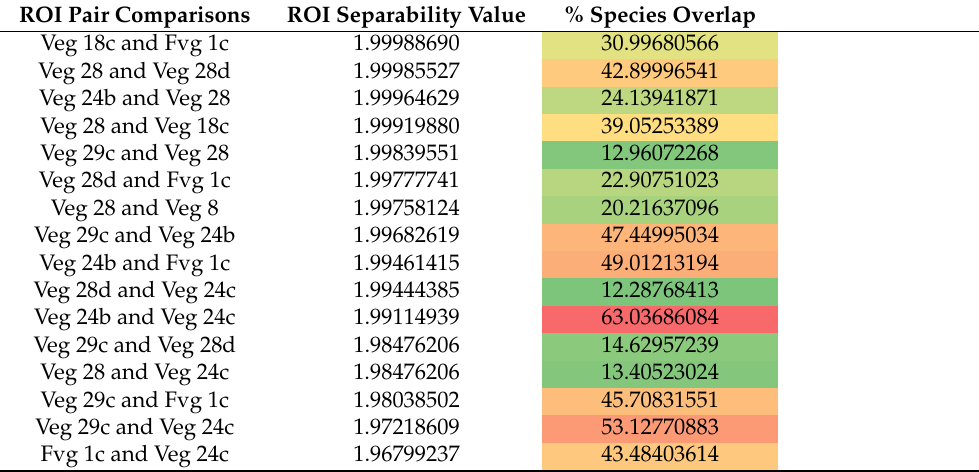
Table 5. Tabulated representation of vegetation utilization as fodder for the different elephant groupings based on the acceptance rating by the different gender grouping based on findings by Greyling [38] as in Table A4. The vegetation categorization has been generalized to genus type and their total dominance within each vegetation community summed up for this assessment. The total point statistics extracted from the classification raster show concentrations of elephants in spatial and numbers contexts, as well as elephant gender groupings. The colour scale indexing ranges from the highest number of elephant points associated with a movement track in green, to the least in yellow. The ‘+’ indicator is used to illustrate elephant presence in instances where the specific number of elephants was not documented during data collection. The representation of the utilised vegetation type is such that either one acceptance icon is used for instances where only one gender grouping was recorded, or two icons separated using ‘/’ that represent the acceptance by either of the gender groupings in order of the listing in the column ‘Grouping’.